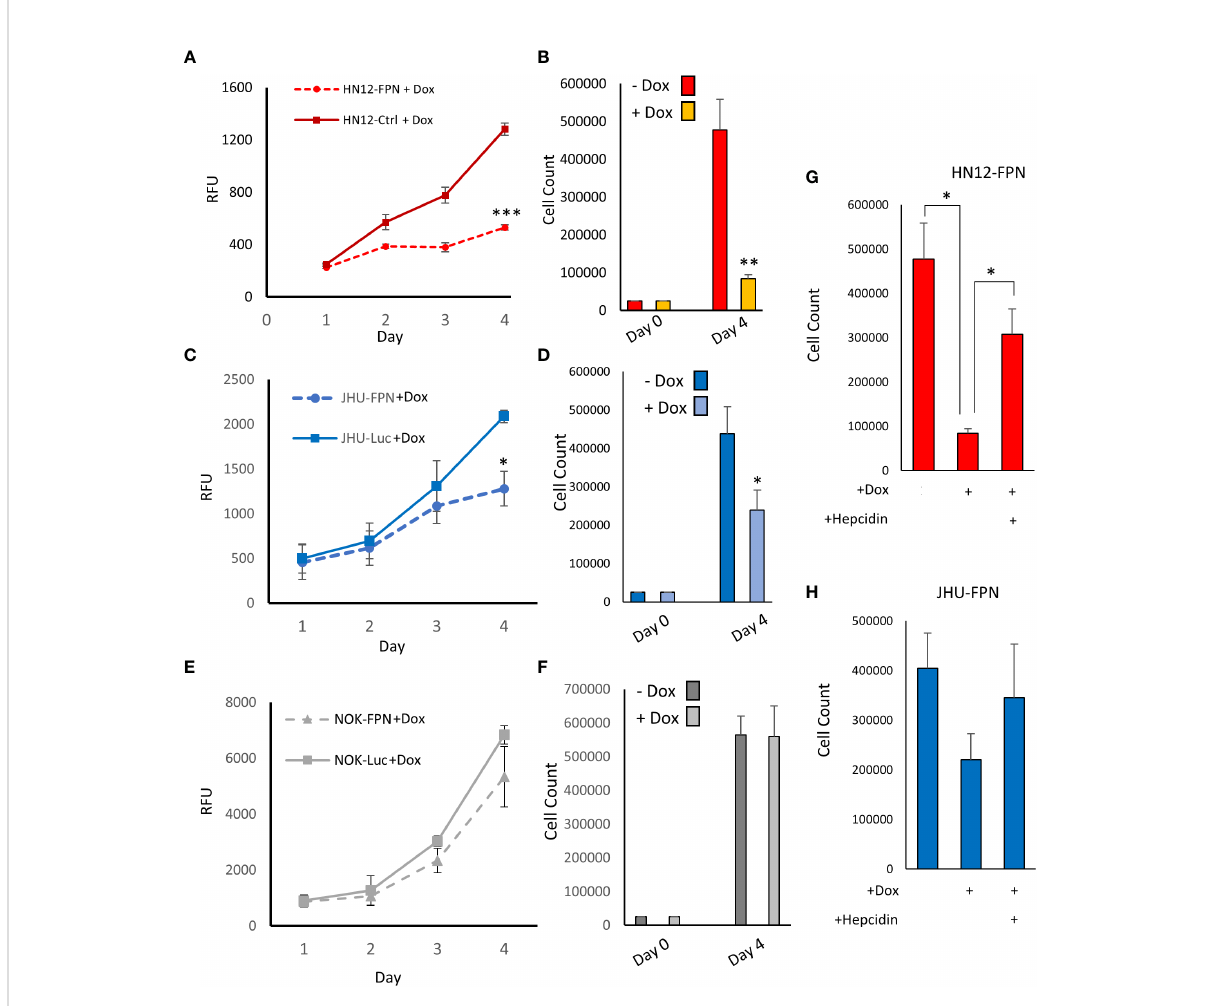
FIGURE 3 Expression of Ferroportin inhibits growth and proliferation of HNSCC. HN12 (A) , JHU-022 (C) and NOK (E) FPN expressing or Luc control expressing cells were seeded in 96 well plates at 1000 cells per well with 0.25 m g/mL dox and grown for 4 days. Growth was assessed using CellTiter-Blue reagent. HN12-FPN (B) , JHU-022-FPN (D) , and NOK-FPN (F) cells were seeded at 25,000 cells per well in a 6-well plate +/- 0.25 m g/mL dox. After 4 days cells were counted via hemocytometer. HN12-FPN (G) and JHU-FPN (H) were seeded in 6 well plates and treated with doxycycline (0.25 m g/mL), hepcidin (10 m M), or left untreated. Cells were grown for 4 days, after which cells were trypsinized and counted via hemocytometer. (*P<0.05; **P<0.01; ***P<0.001). All data is representative of 3 biological